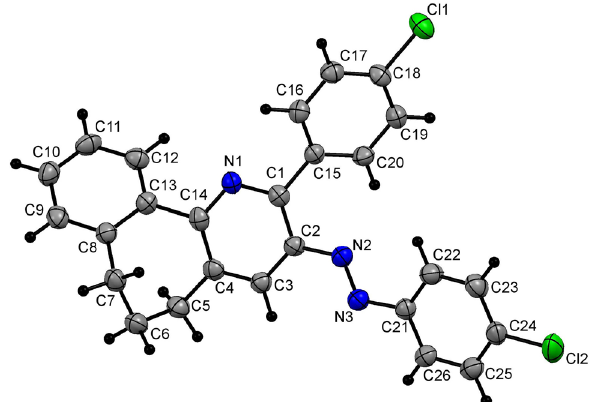
Figure 2. X-ray plot of single crystallographic data collected for 4a . Mercury (version 3.8) (https ://www.ccdc. cam.ac.uk/solut ions/csd-syste m/compo nents /mercu ry/) was used to create this figure.